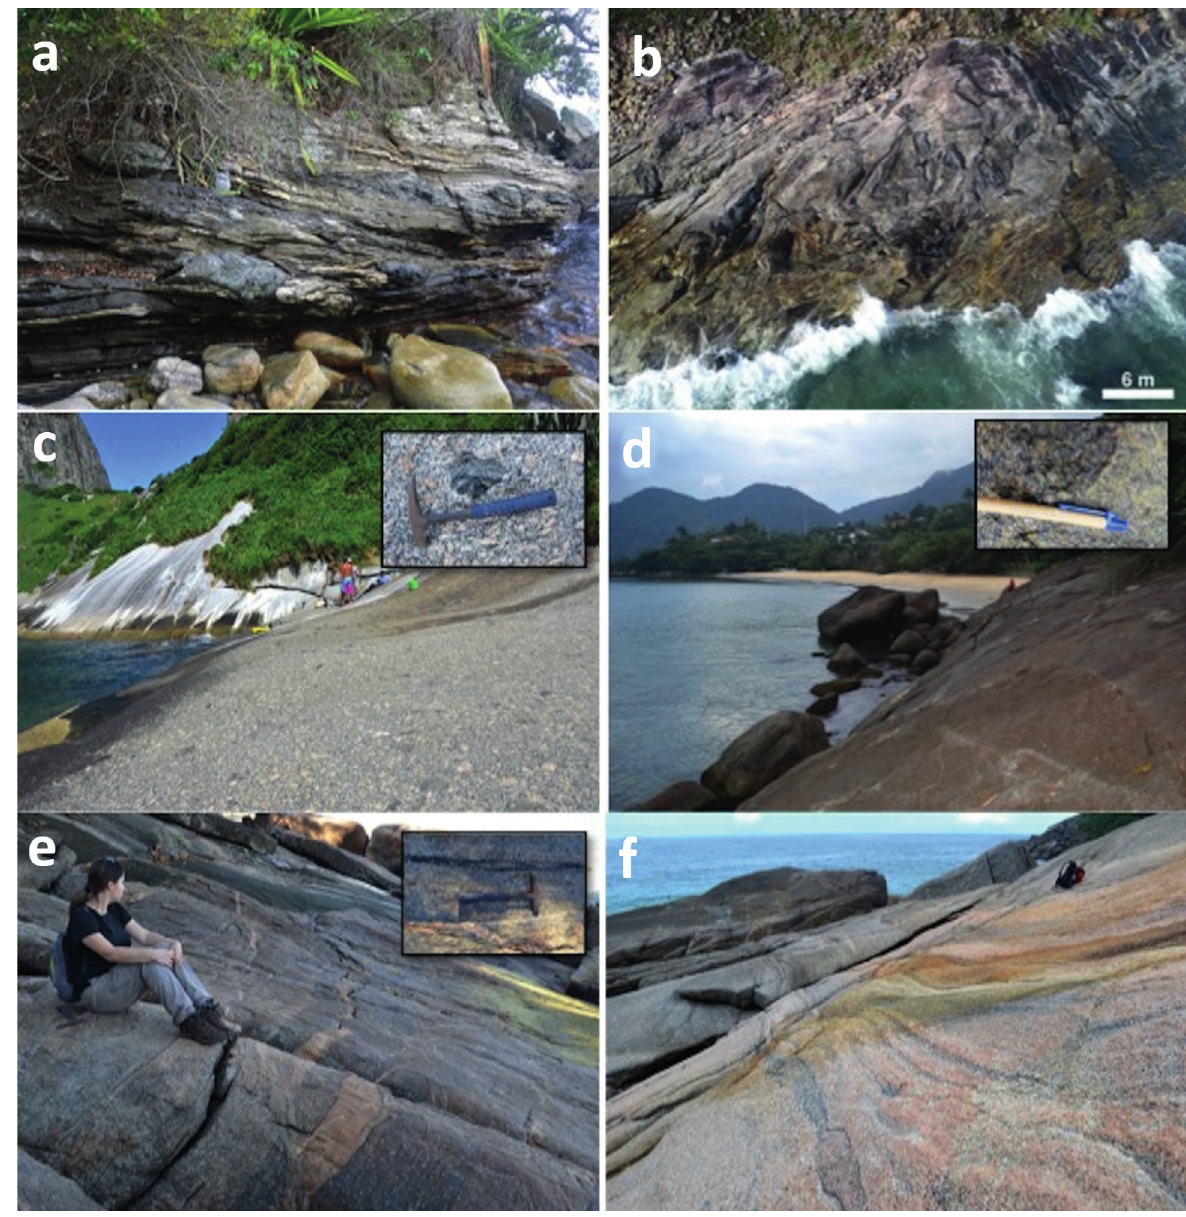
Figure 2 - representative geosites of the geological frameworks (GF) related to the Brasiliano-Pan African Cycle (Neoproterozoic- Cambrian). GF Costeiro Complex terranes: a ) Geosite “Costeiro Complex at Portinho Beach”. this site consists of a section showing complex relationships between lithotypes from the basement and calc-silicate rocks; b ) Geosite “Metatexitic paragneisses and amphibolites of Boiçucanga”. Sillimanite –garnet-bearing metatexitic biotite gneisses associated to amphibolite boudins; GF Syntectonic granitic magmatism: c ) Geosite “Alcatrazes Granite type-locality”. d ) Geosite “Mangerite of the Ubatuba suite in Santa rita Beach”. Similar ages were obtained by other authors - 582 Ma - Janasi et al. (2015), tassinari et al. (2008); GF Strike- slip tectonics and shear zones: e ) Geosite “Mylonites of tabatinga Beach and tamanduá Island”. An example of the strike-slip shear zones that result from the escape tectonics that gave origin to transpressive, linear domains in the Southeast of Brazil. Similar mylonitic foliations are observed both in the continent and in the island; GF Cambro-Ordovician post-tectonic magmatism: f ) Geosite “Ilha Anchieta Monzogranite”. this 500-Ma monzogranite outcrop represents the collapse stage of the Brasiliano-Pan African Orogeny and shows pervasive igneous planar structures that represent primary